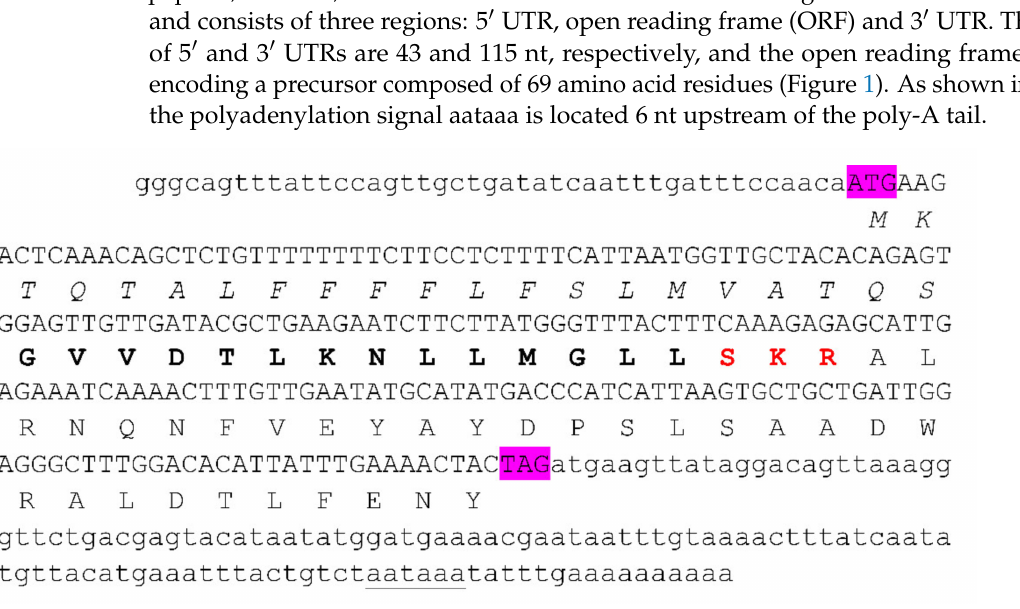
Figure 1. Precursor nucleotide sequences and the deduced amino acid sequences of the scorpion venom peptide Ctri9594 from Chaerilus tricostatus . The sequences of 5 (cid:48) UTR and 3 (cid:48) UTR are lowercase letters. The sequences of the open reading frame (ORF) are capital letters. The initial codon ATG and the terminal codon TAG are highlighted in purple. A potential polyadenylation signal aataaa is underlined. The predicted amino acid sequences are shown below the corresponding nucleotide sequences. The signal peptide residues are italicized. The mature peptide residues are highlighted in bold. The post-translational processing signal (SKR) is in